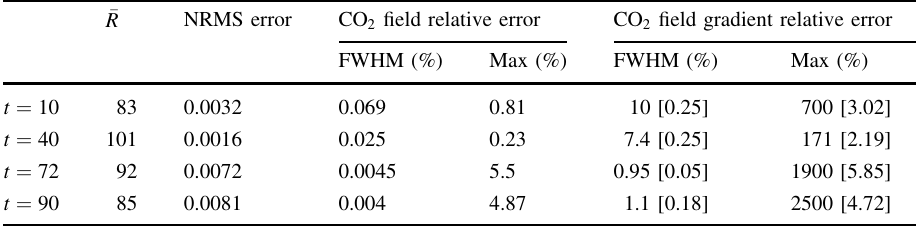
Table 1 Compression ratio R , NRMS error and relative error statistics in the reconstructed CO 2 species concentration field and its gradient for different time steps of RCCI simulation